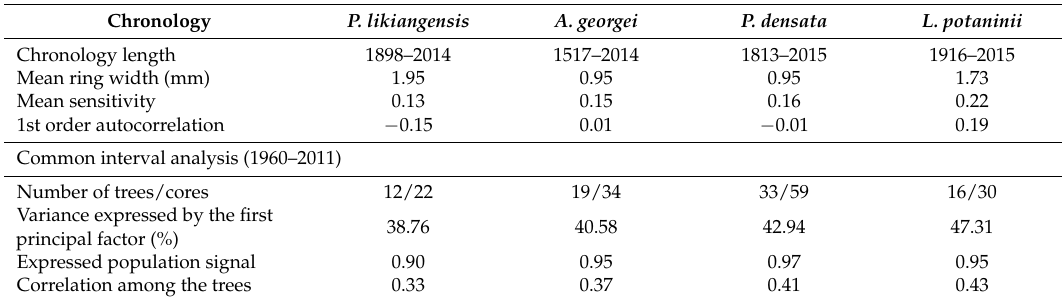
Table 2. Statistics of residual chronologies and common interval